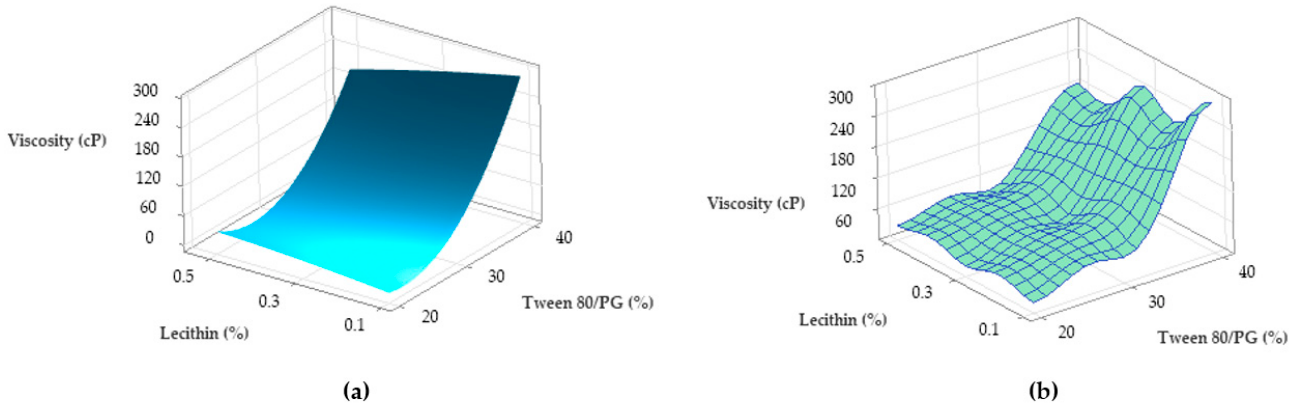
Figure 13. Surface plots representing viscosity response (Y 1 ) as a function of Tween 80/PG (%) and Lecithin (%): ( a ) Surface representation in gradient color, and ( b ) Wireframe model.